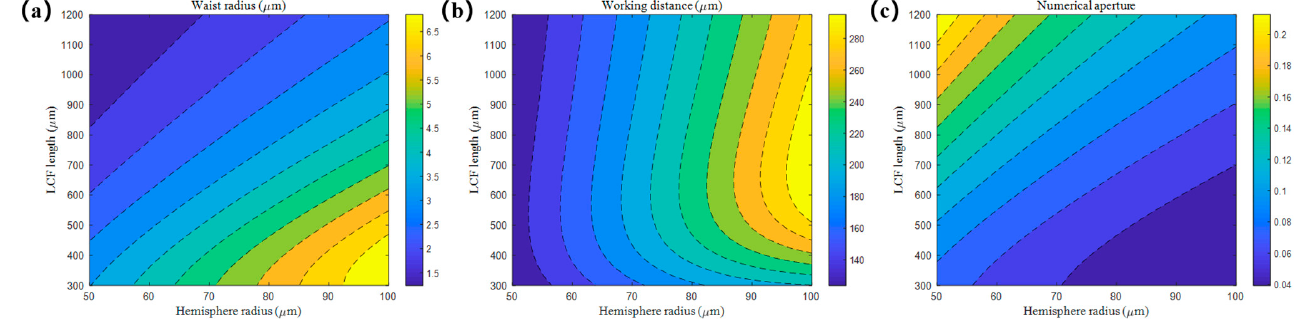
Figure 3. Simulation of the hemisphere radius and LCF length for the lensed fiber output: ( a ) waist radius; ( b ) working distance; and ( c ) numerical aperture. The dashed line in the figure is the equipotential line.